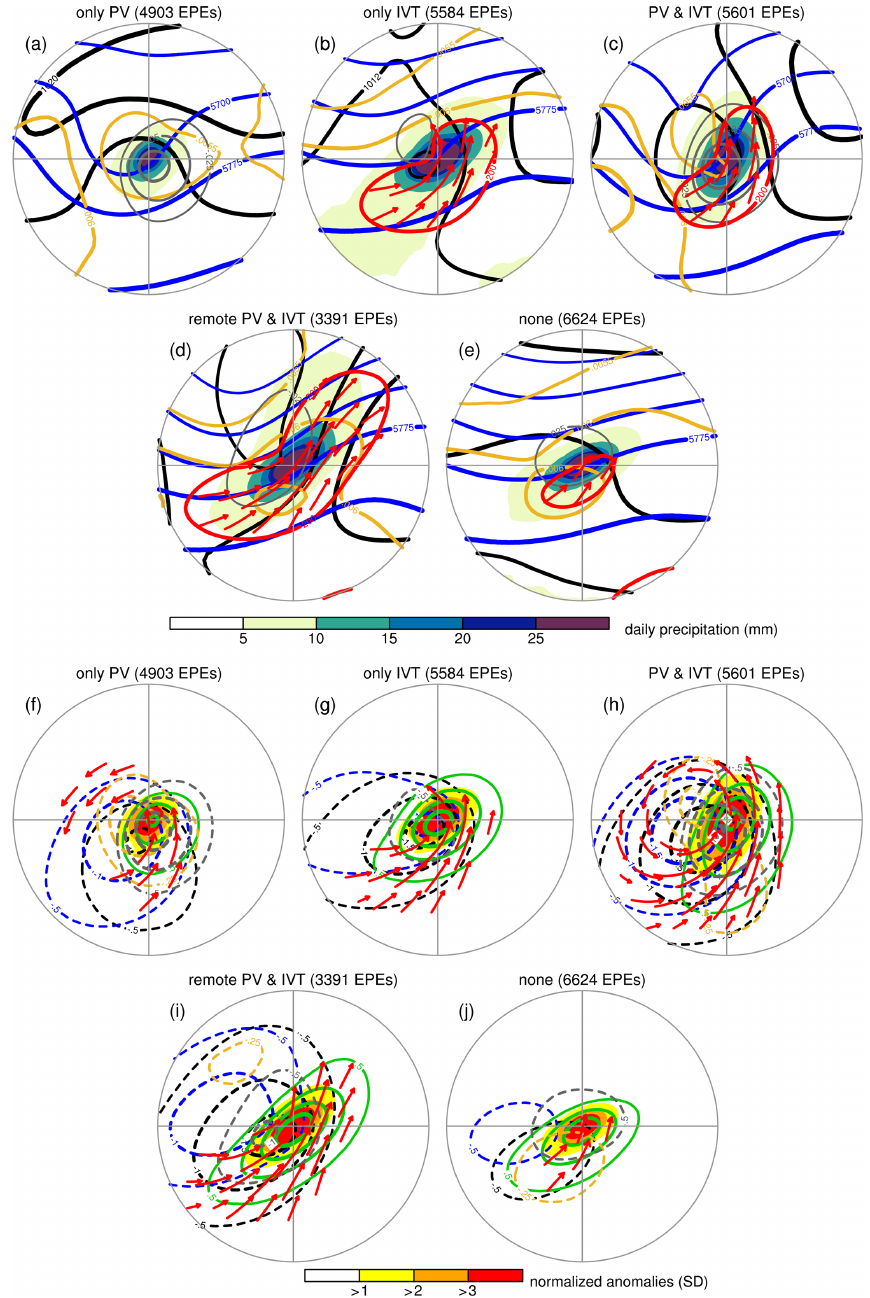
Figure 12. As in Fig. 11, but for EPEs over subtropical